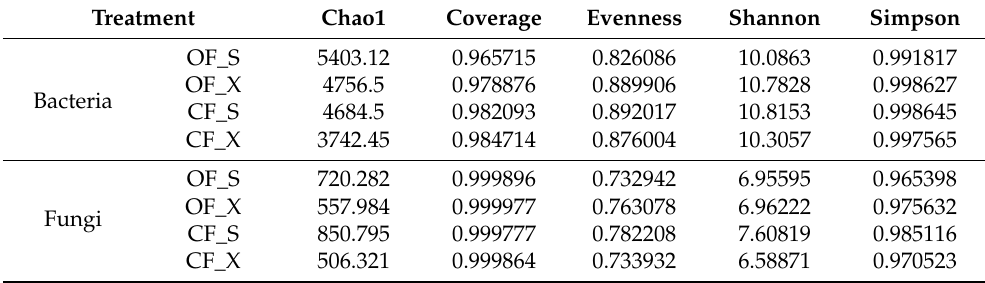
Table 2. Alpha diversity of microorganisms in upper and lower soil layers under two cultivation